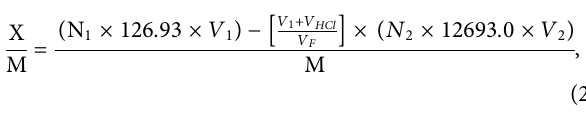
TABLE 2 | Iodine number of Cu-PDA MOF for metal to ligand in different ratio. Sample Metal to ligand precursor ratio